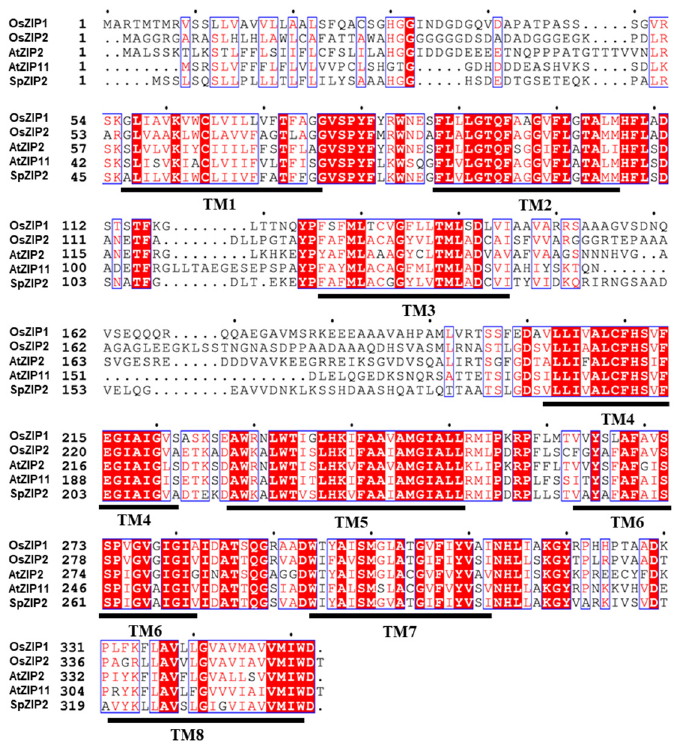
Figure 4. Sequence alignment of SpZIP2 and ZIP members from rice and A. thaliana . Strictly conserved residues are highlighted in red. The corresponding positions of the predicted 8 transmembrane regions are indicated as TM1 to TM8 below the corresponding sequence.